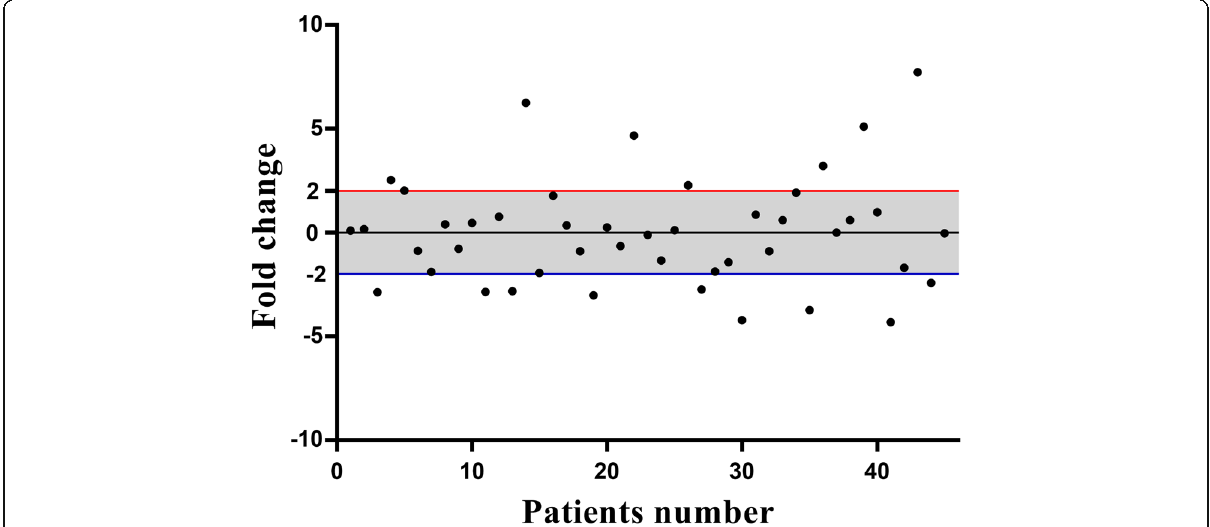
Fig. 1 Descriptive analysis of relative MAEL gene expression in ESCC patients. The thresholds for the over and under expressed cases are shown by the red and blue lines, respectively. The grey area mentions to the cases with normal levels of MAEL mRNA